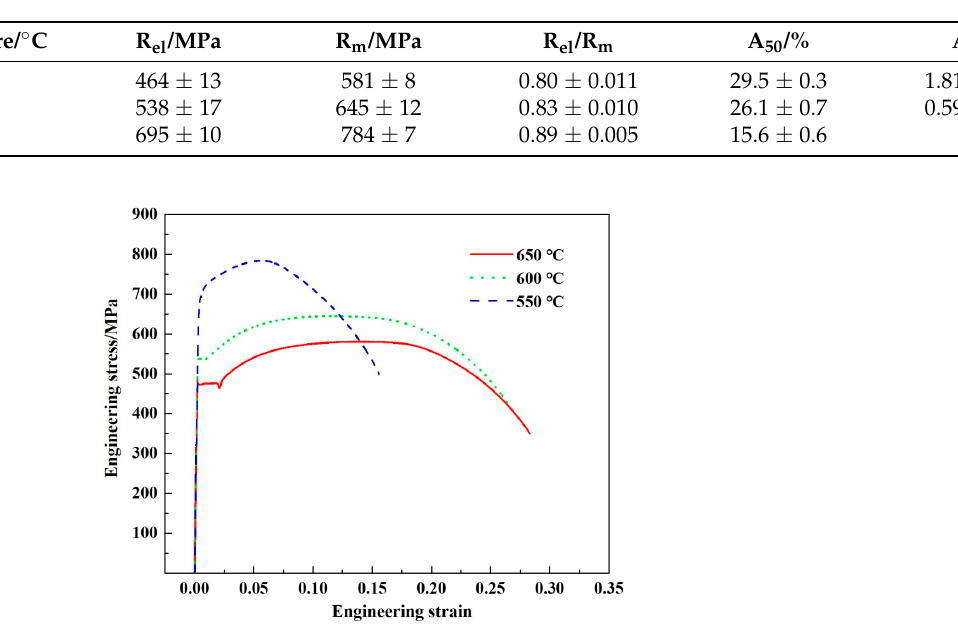
Figure 4. Engineering stress–strain curves of test steel at di ff erent coiling temperatures.